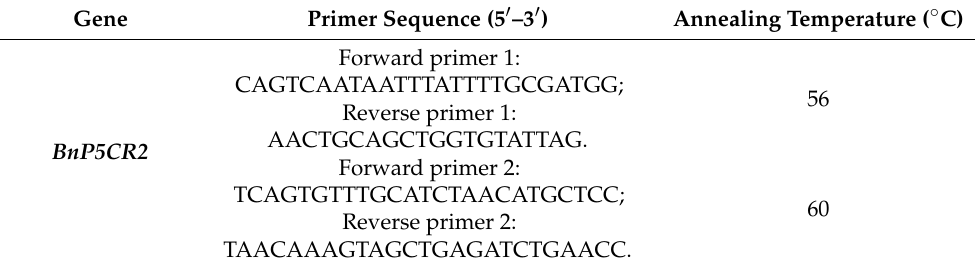
Table 1. The primers information of BnP5CR2 gene. Gene Primer Sequence (5 (cid:48) –3 (cid:48)